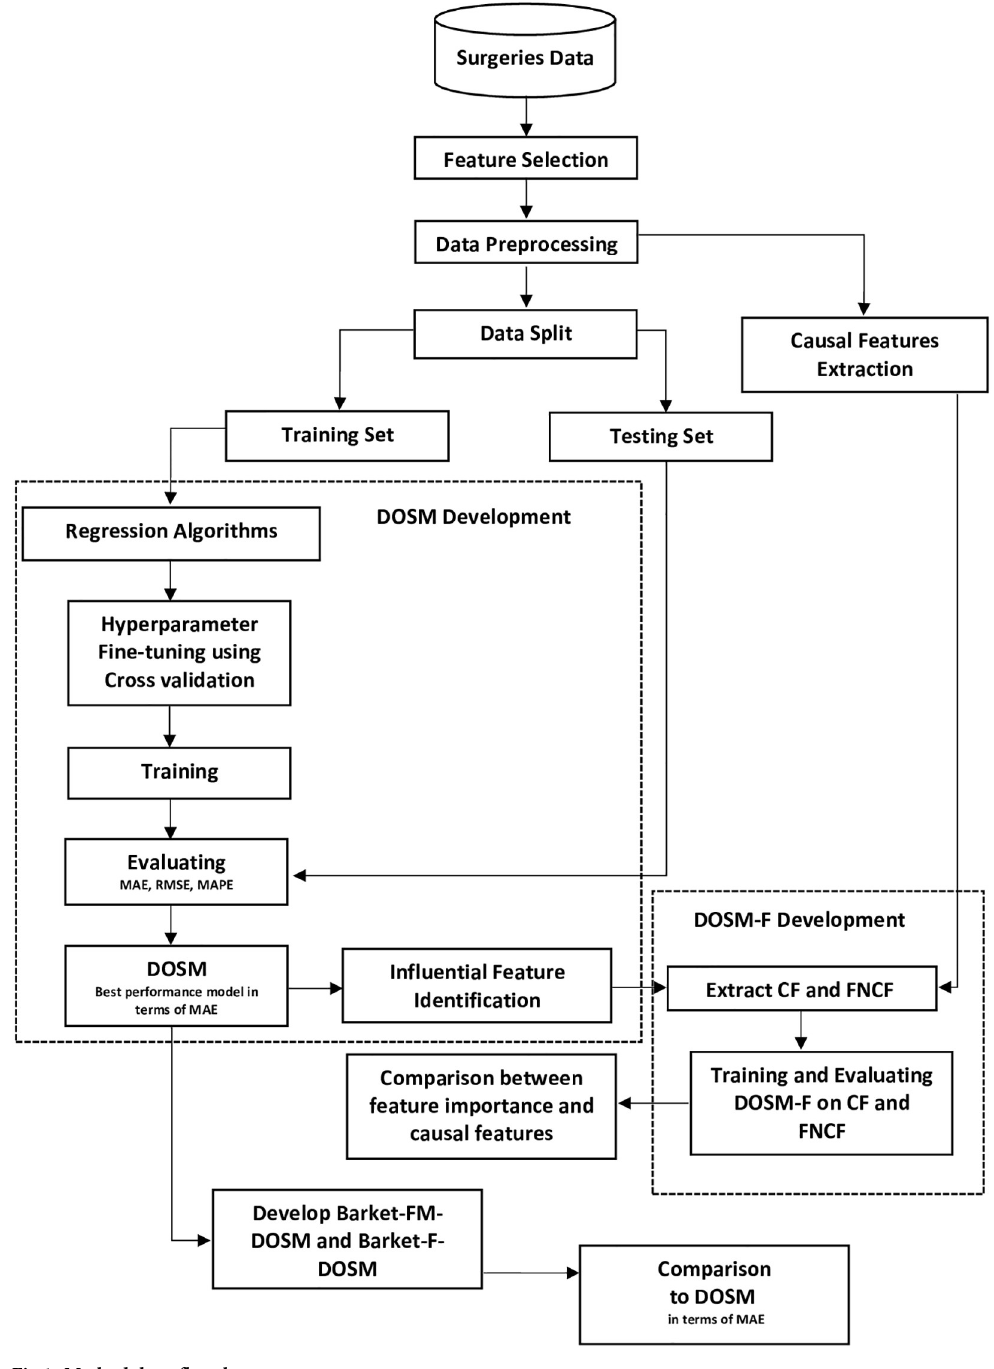
Fig 1. Methodology